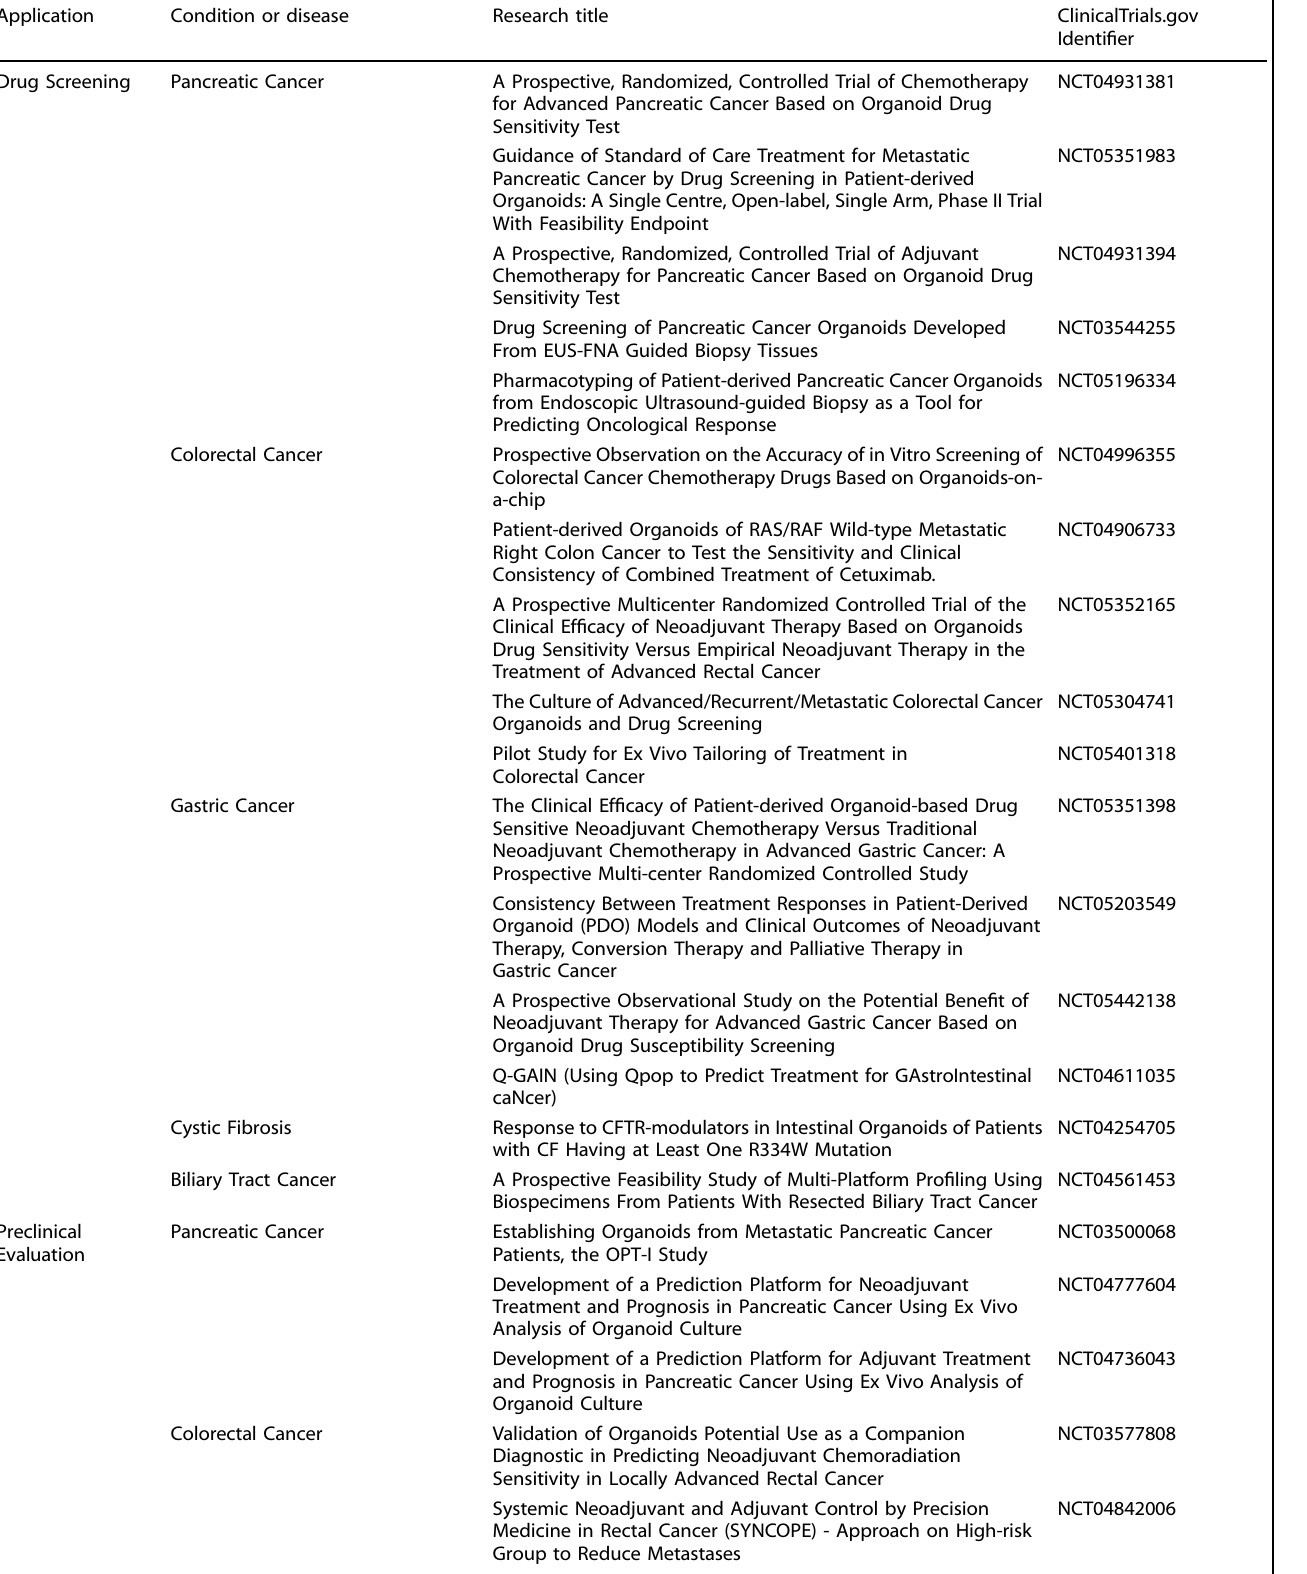
Table 2. Summary of organoid-based clinical trails